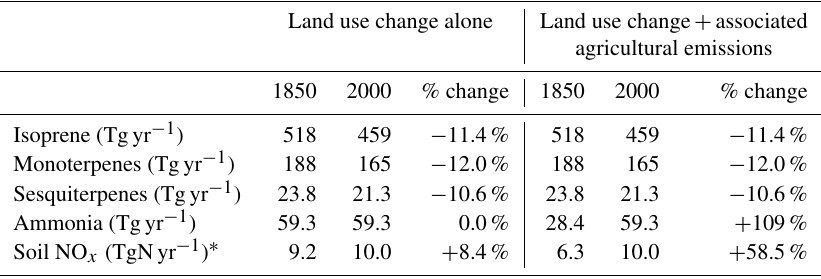
Table 3. Annual average emissions impacted by historical land use change alone; shown separately are changes in emissions due to both land use change and associated agricultural emissions.